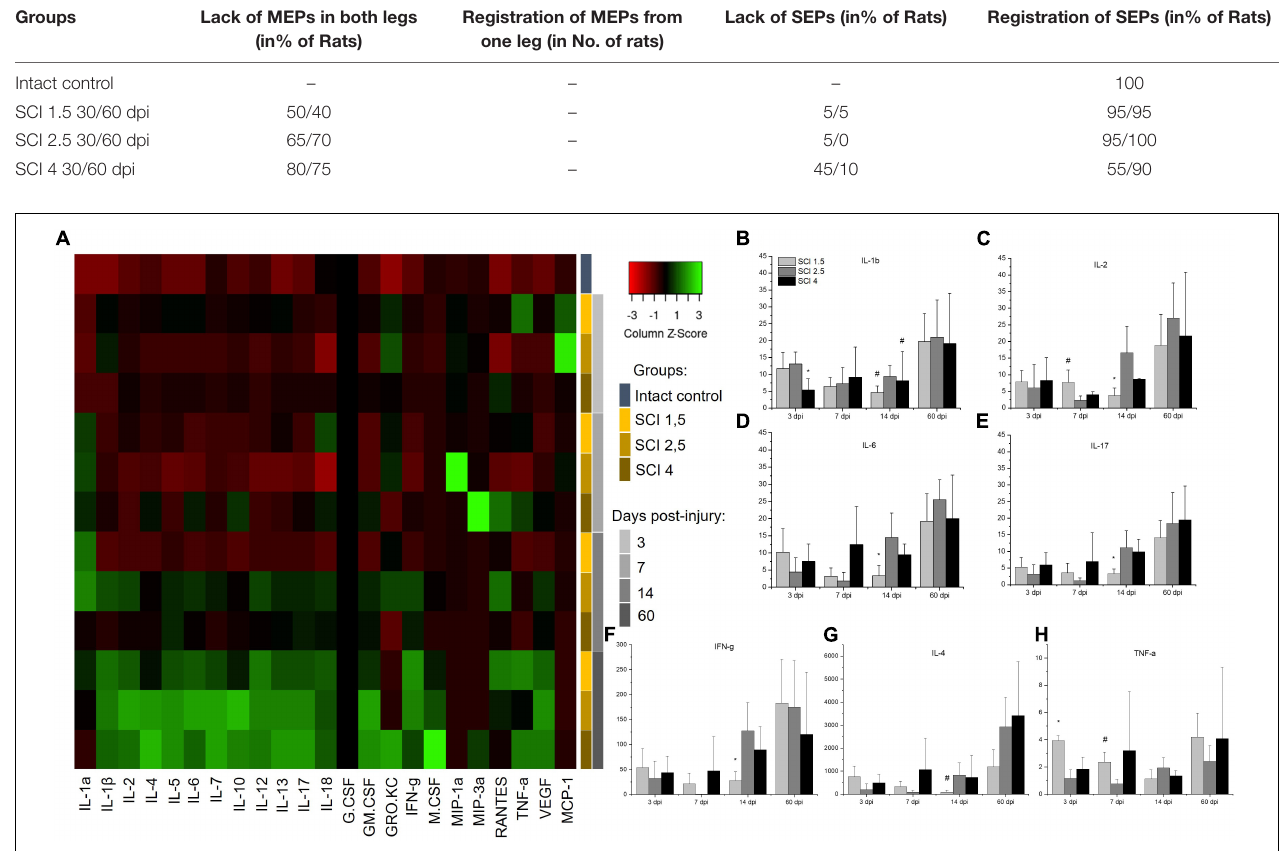
TABLE 1 | Results of transcranial electrical stimulation and motor evoked potential (MEP)/scalp somatosensory evoked potential (SEP) registration in rats. Groups Lack of MEPs in both legs (in% of Rats)